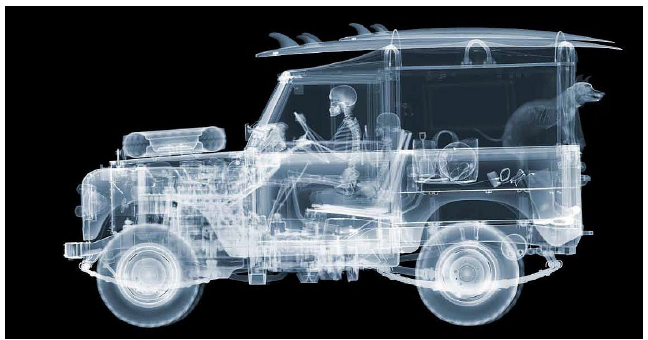
Fig. 7 Nick Veasey, 1972 Land Rover Surfer , 2018. ÆRENA Galleries and Gardens, Ed. 12/25